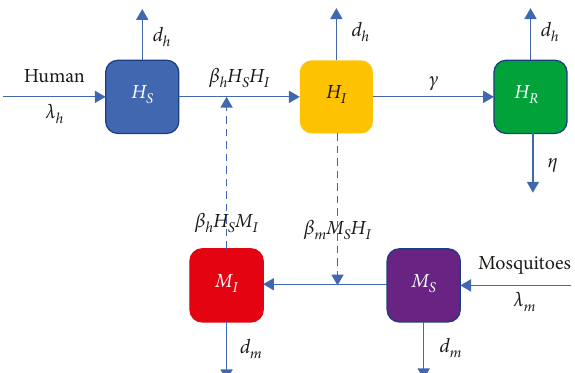
Figure 1: Transmission and dynamics of Zika virus infection between the host (human) and the vector